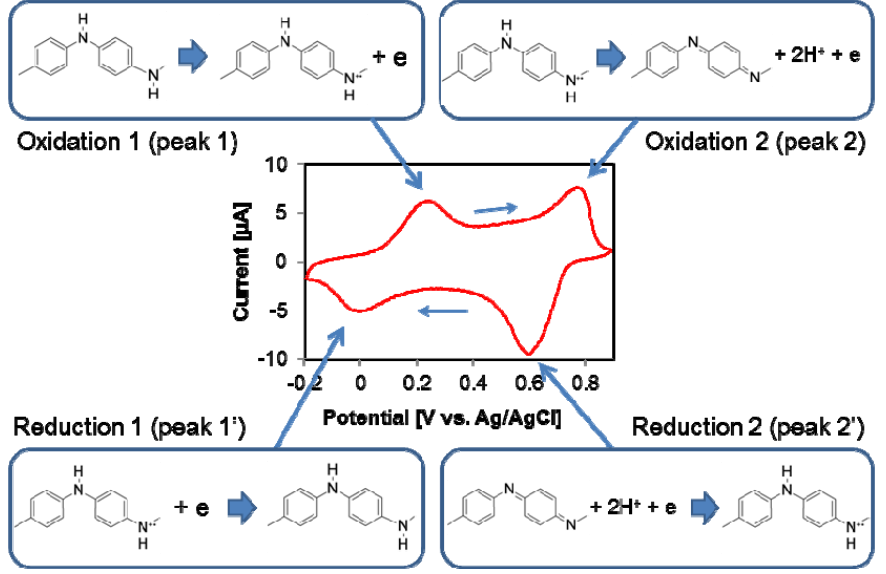
Figure 3. A typical cyclic voltammetry (CV) curve of polyaniline in HCl (pH 1) showing two sets of redox couples. The direction of potential scan is shown with the